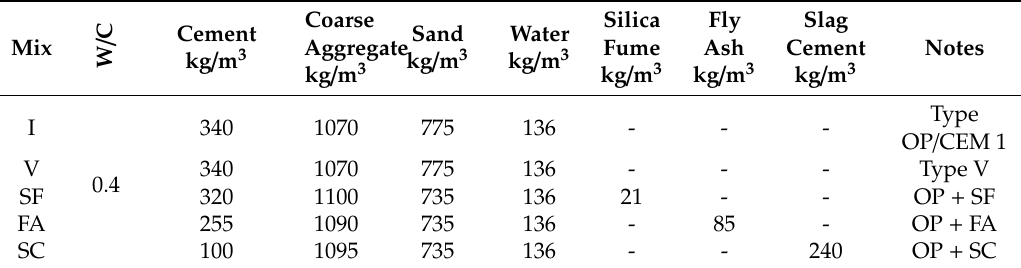
Table 1. Mix proportioning.